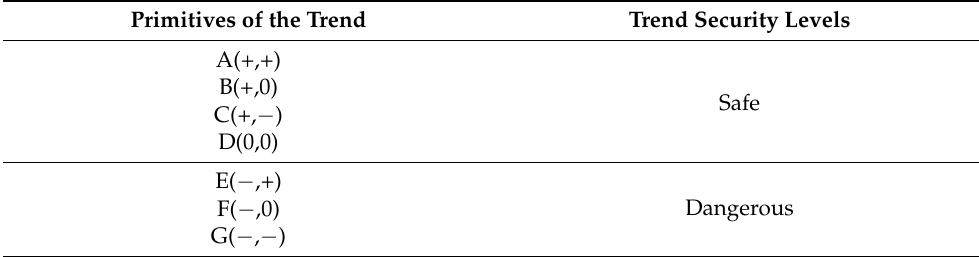
Table 1. The table of safety level.